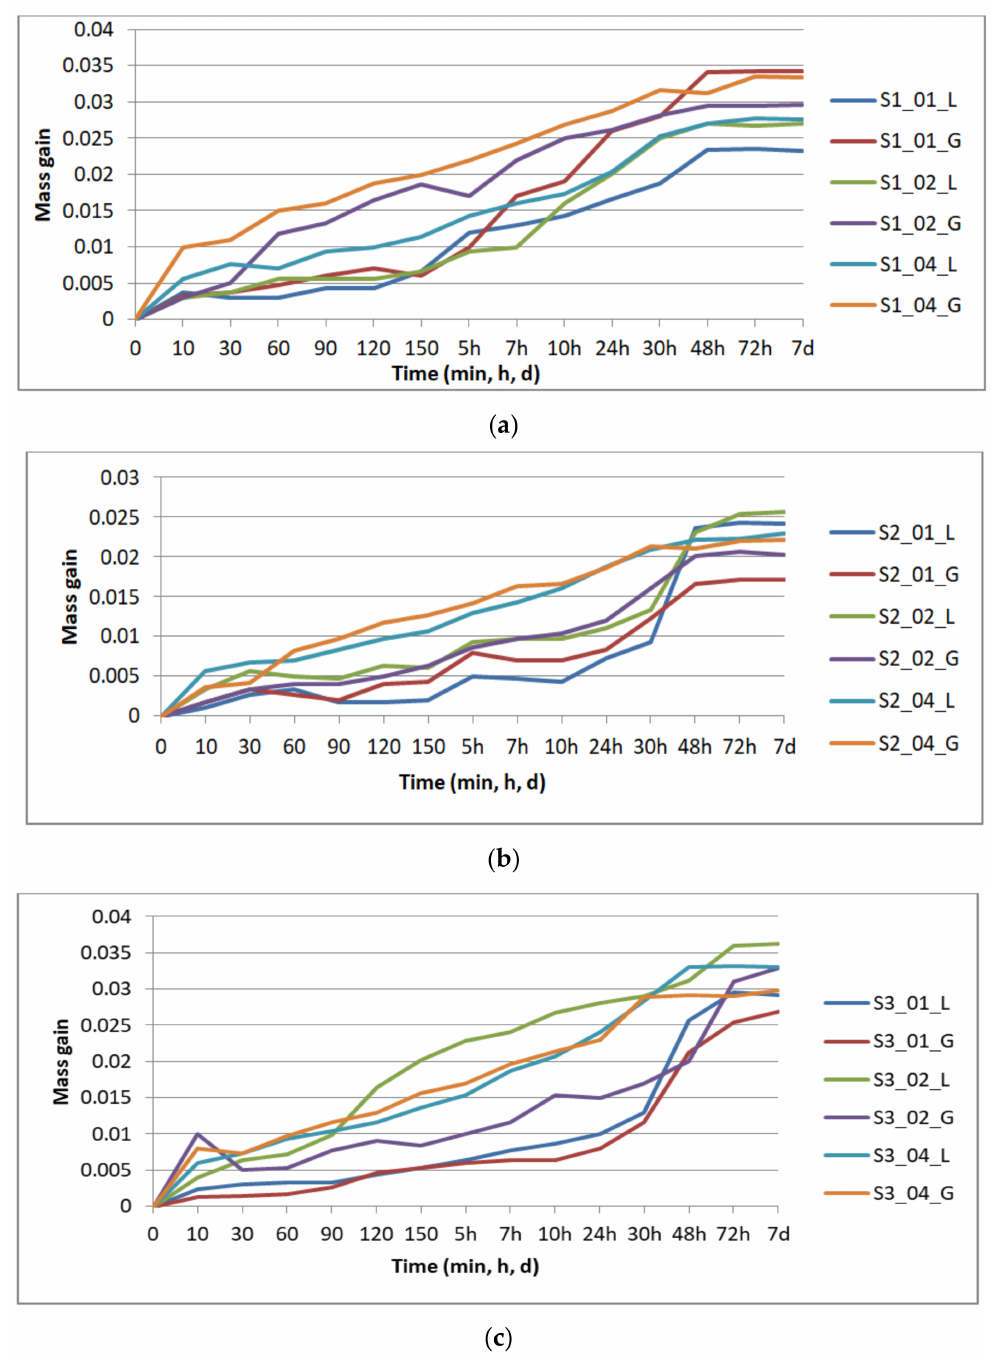
Figure 4. Disinfectant absorption for specimens 3D-printed with one perimeter ( a ), two perimeters ( b ), and three perimeters ( c